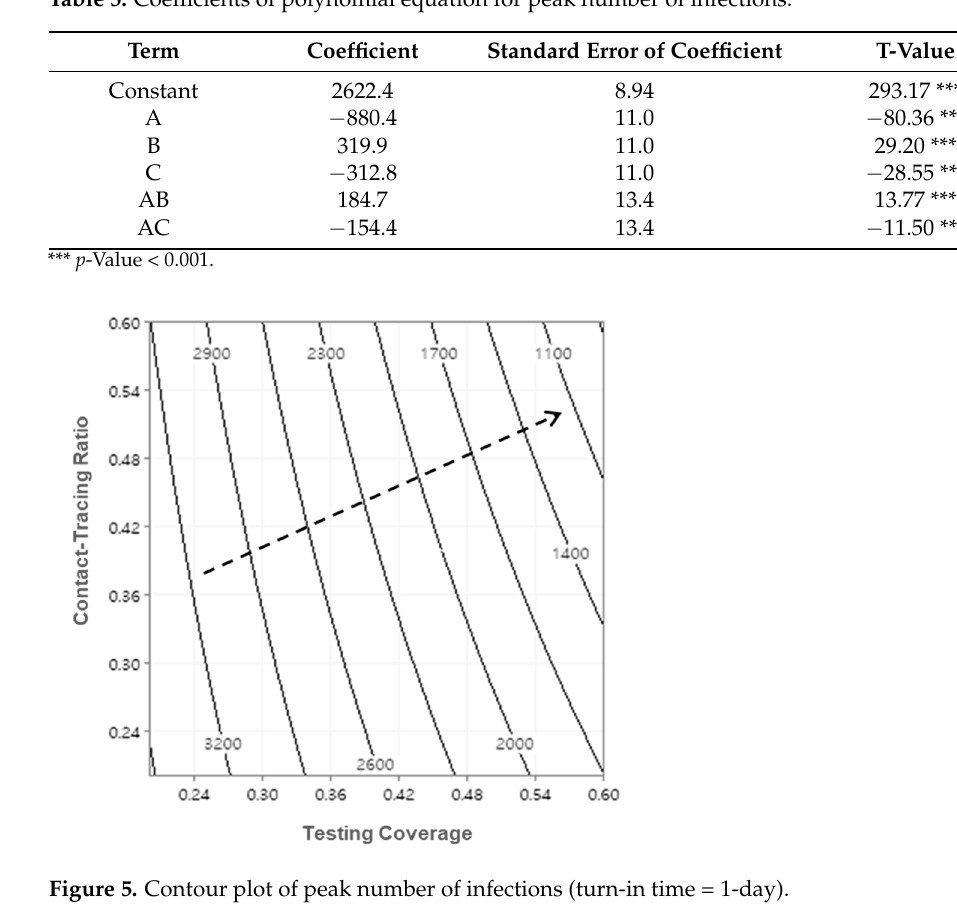
Table 5. Coefficients of polynomial equation for peak number of infections.